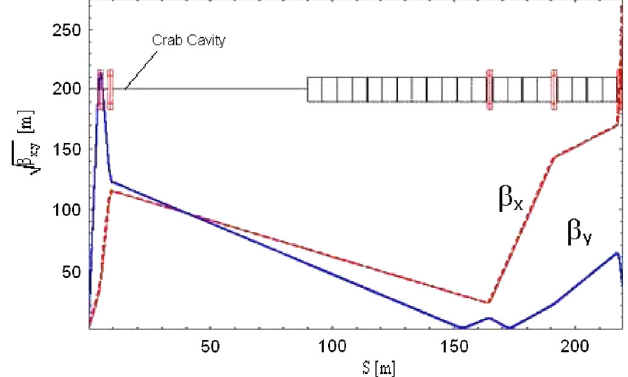
FIG. 2. (Color) The ILC BDS lattice showing the beta